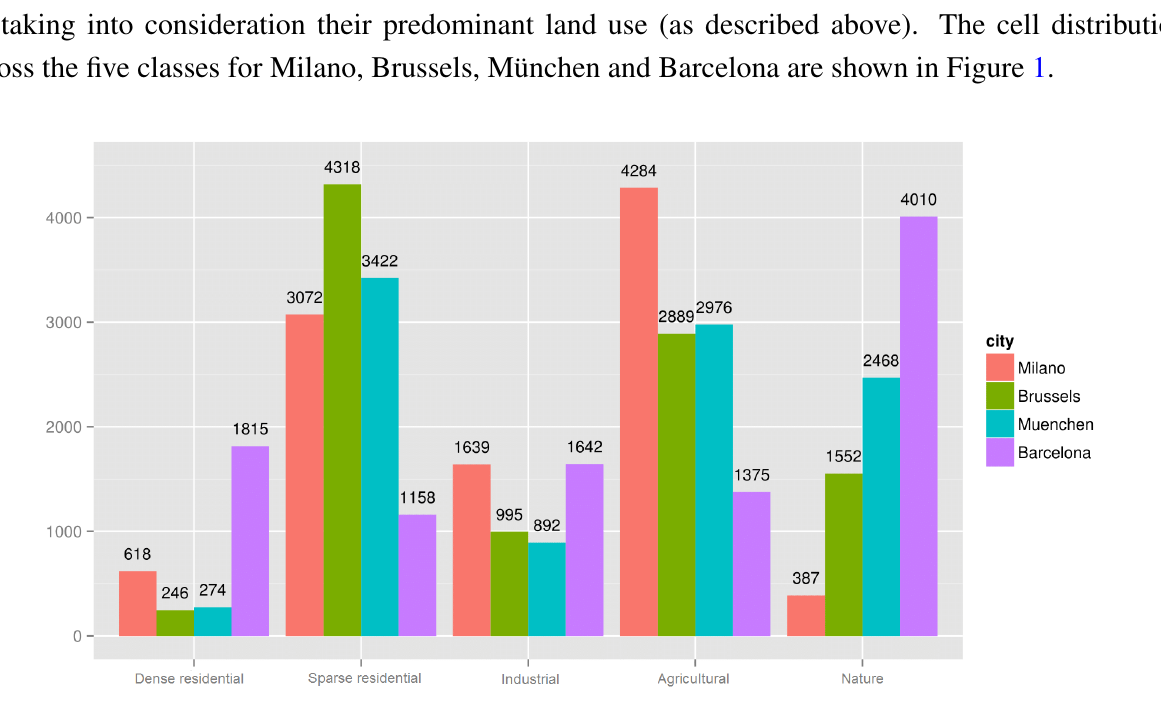
Figure 1. Cell distributions in the selected cities